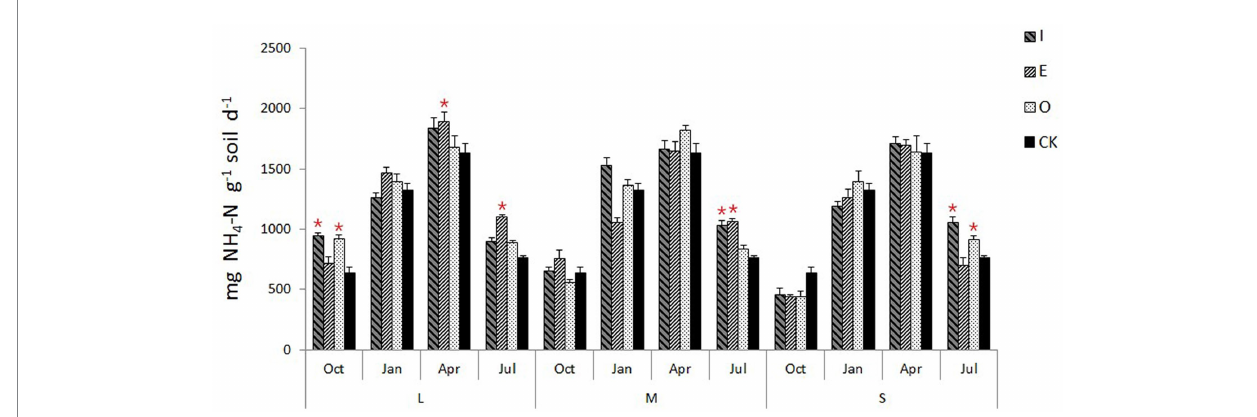
FIGURE 6 Soil urease activity of different position in different sizes of gaps, the “*“signs represent significant differences.